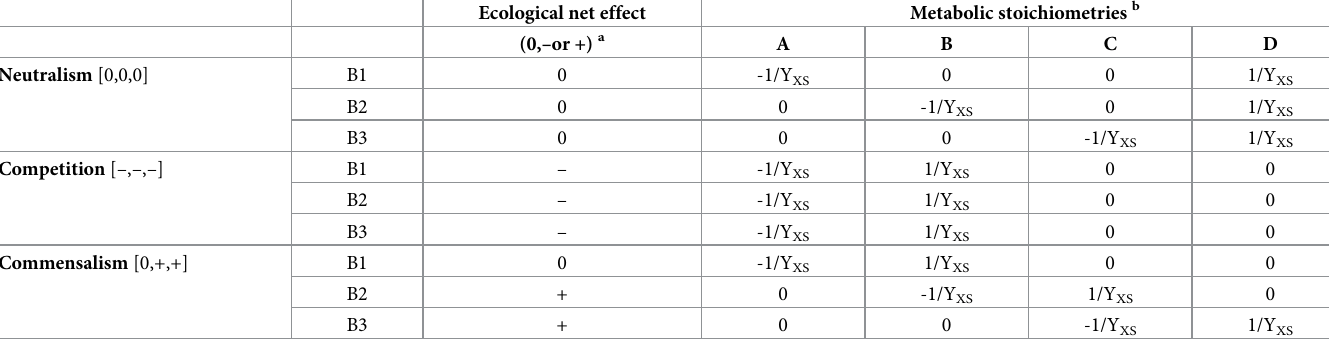
Table 1. Definition of eco-interactions. Summary of ecological net effect on bacteria and their respective metabolic